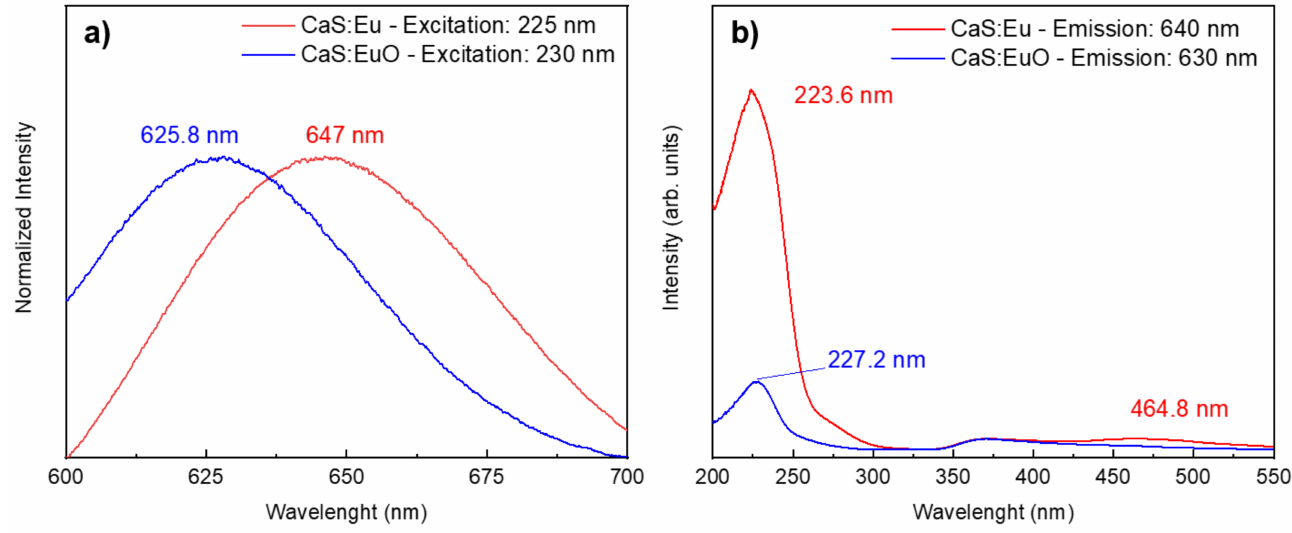
Figure 6. ( a ) Normalized emission spectra and ( b ) excitation spectra from CaS:Eu and CaS:EuO, measured at room